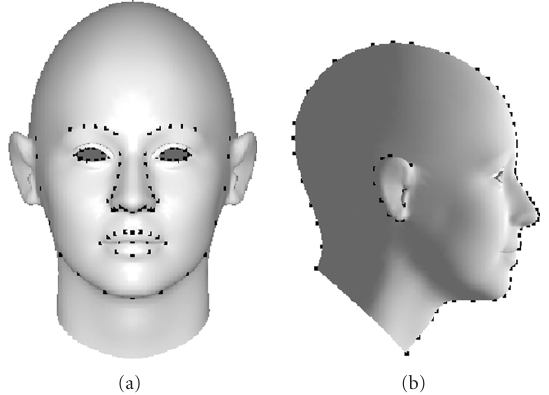
Figure 14: The key points marked in the generic model. (a) Frontal key points. (b) Profile key points.